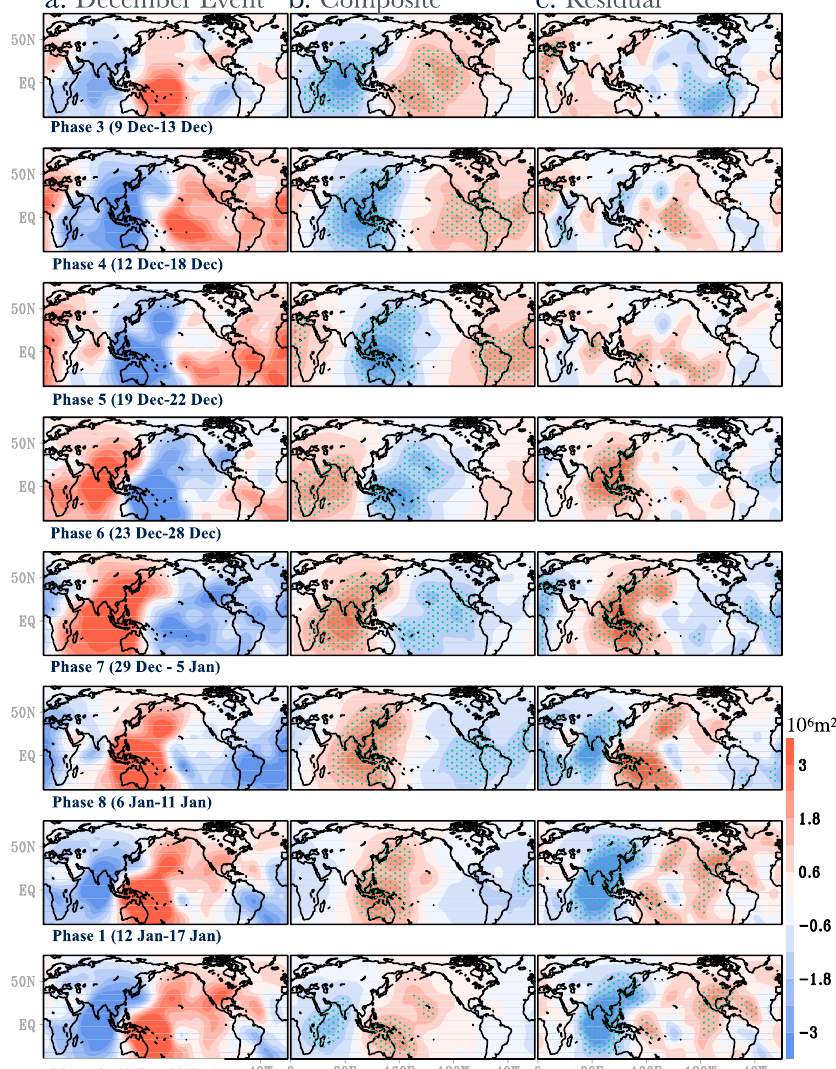
Figure 3. ( a ) 200-hPa velocity potential anomalies based on the eight phases of the December 2015 MJO episode described in the text; ( b ) Composite of 200-hPa velocity potential anomalies based on 25 prior MJO episodes; ( c ) Velocity potential anomalies not linearly explained by the MJO (i.e., linearly regressed construction of the MJO’s impact subtracted from the December event anomalies of χ ). Green stippling show significant areas at the 95% confidence level.